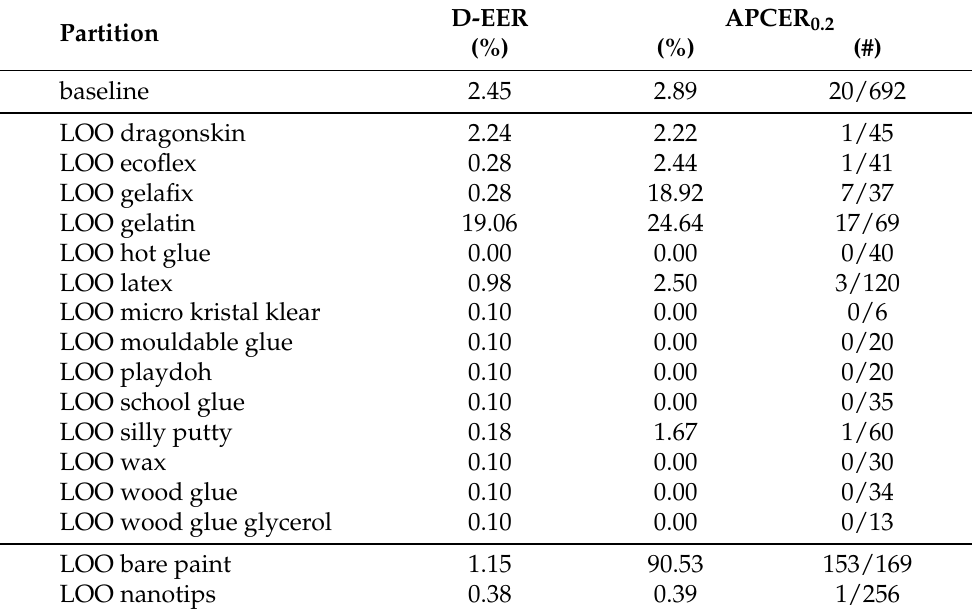
Table 5. Results in terms of D-EER and APCER 0.2 for the particular